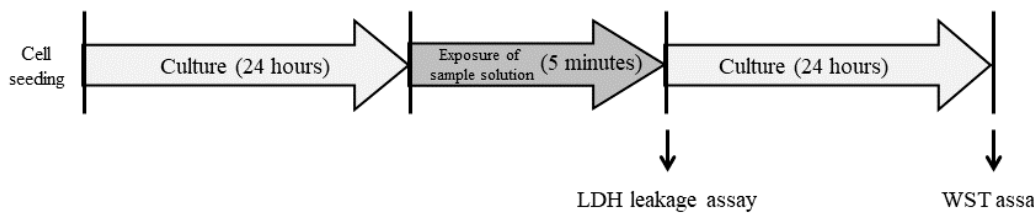
Figure 8. Cytotoxicity test procedure for the BALB/3T3 cells. BALB/3T3 cells that had been cultured in DMEM for 24 h were treated with 100 mL/well of each sample for 5 min. The solution was collected from each well and used for the LDH leakage assay. After the cells had been cultured for 24 h, their viability was assessed.